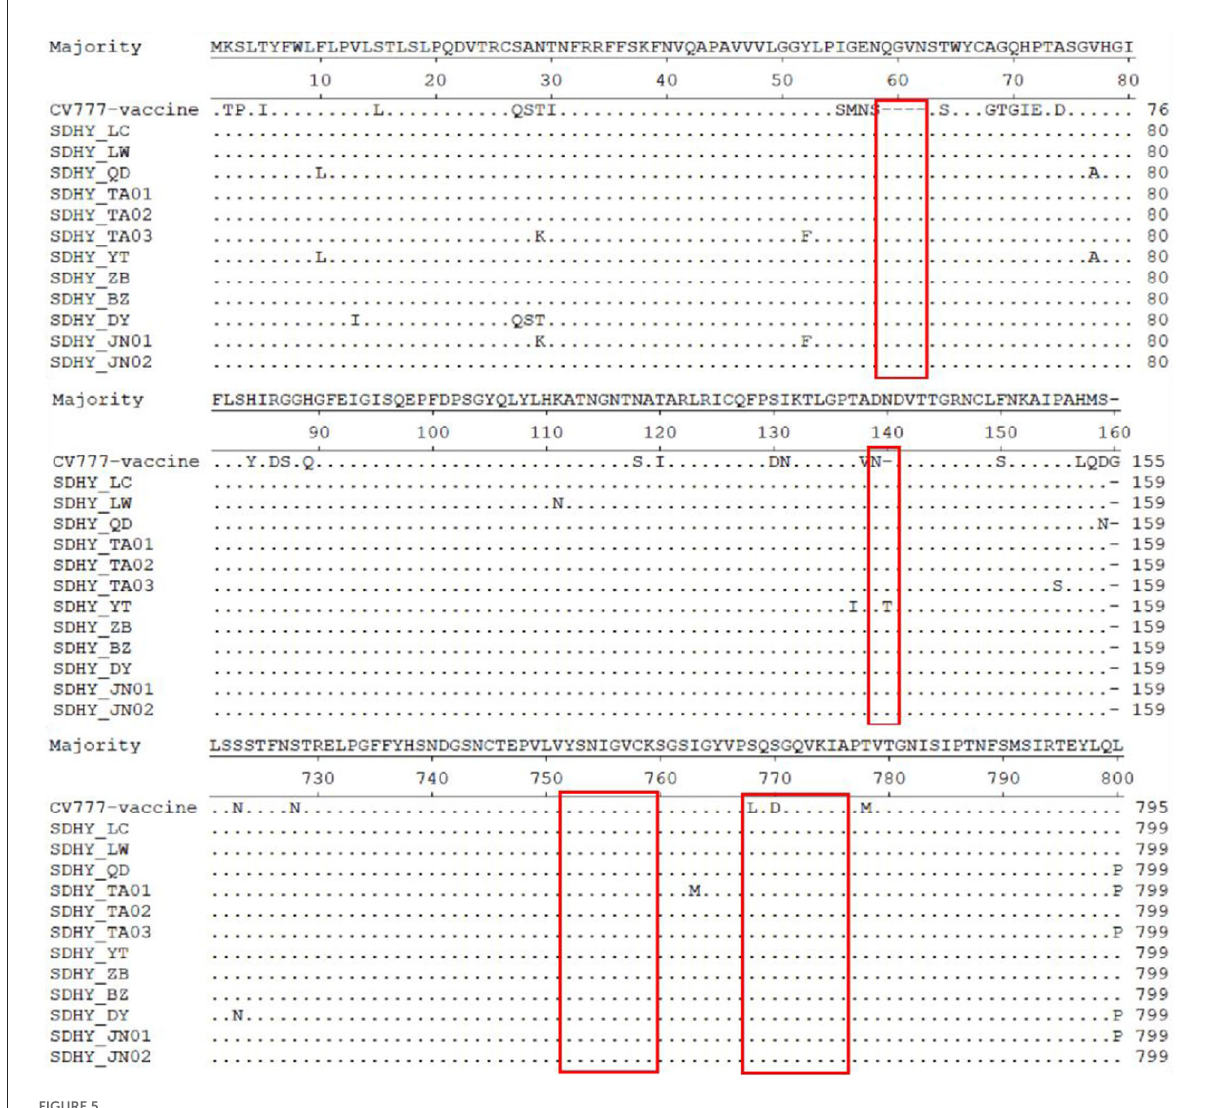
FIGURE5 Analysis and comparison of amino acid of PEDV S